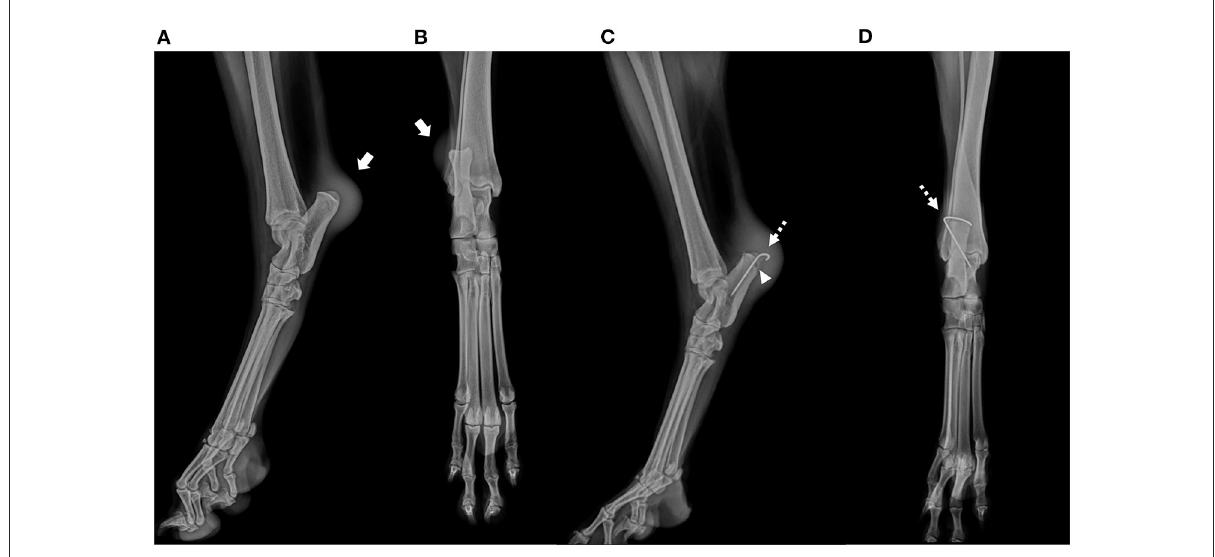
FIGURE1 Preoperative mediolateral (A) and craniocaudal (B) radiographs of the affected right calcaneal region. Note soft tissue swelling in the cauda-ventral aspect of the calcaneal tuber of the right tarsal joint, in absence of bone lesion. (arrow). Postoperative mediolateral (C) and craniocaudal (D) radiographs. Temporary restraining pin placed on the lateral aspect of calcaneal tuber (C,D, dotted arrow) . A 2.4 × 8.5mm biocomposite suture anchor (SutureTak; Arthrex Inc. Naples, FL) placed on medial aspect of calcaneal tuber (C, arrow head) .